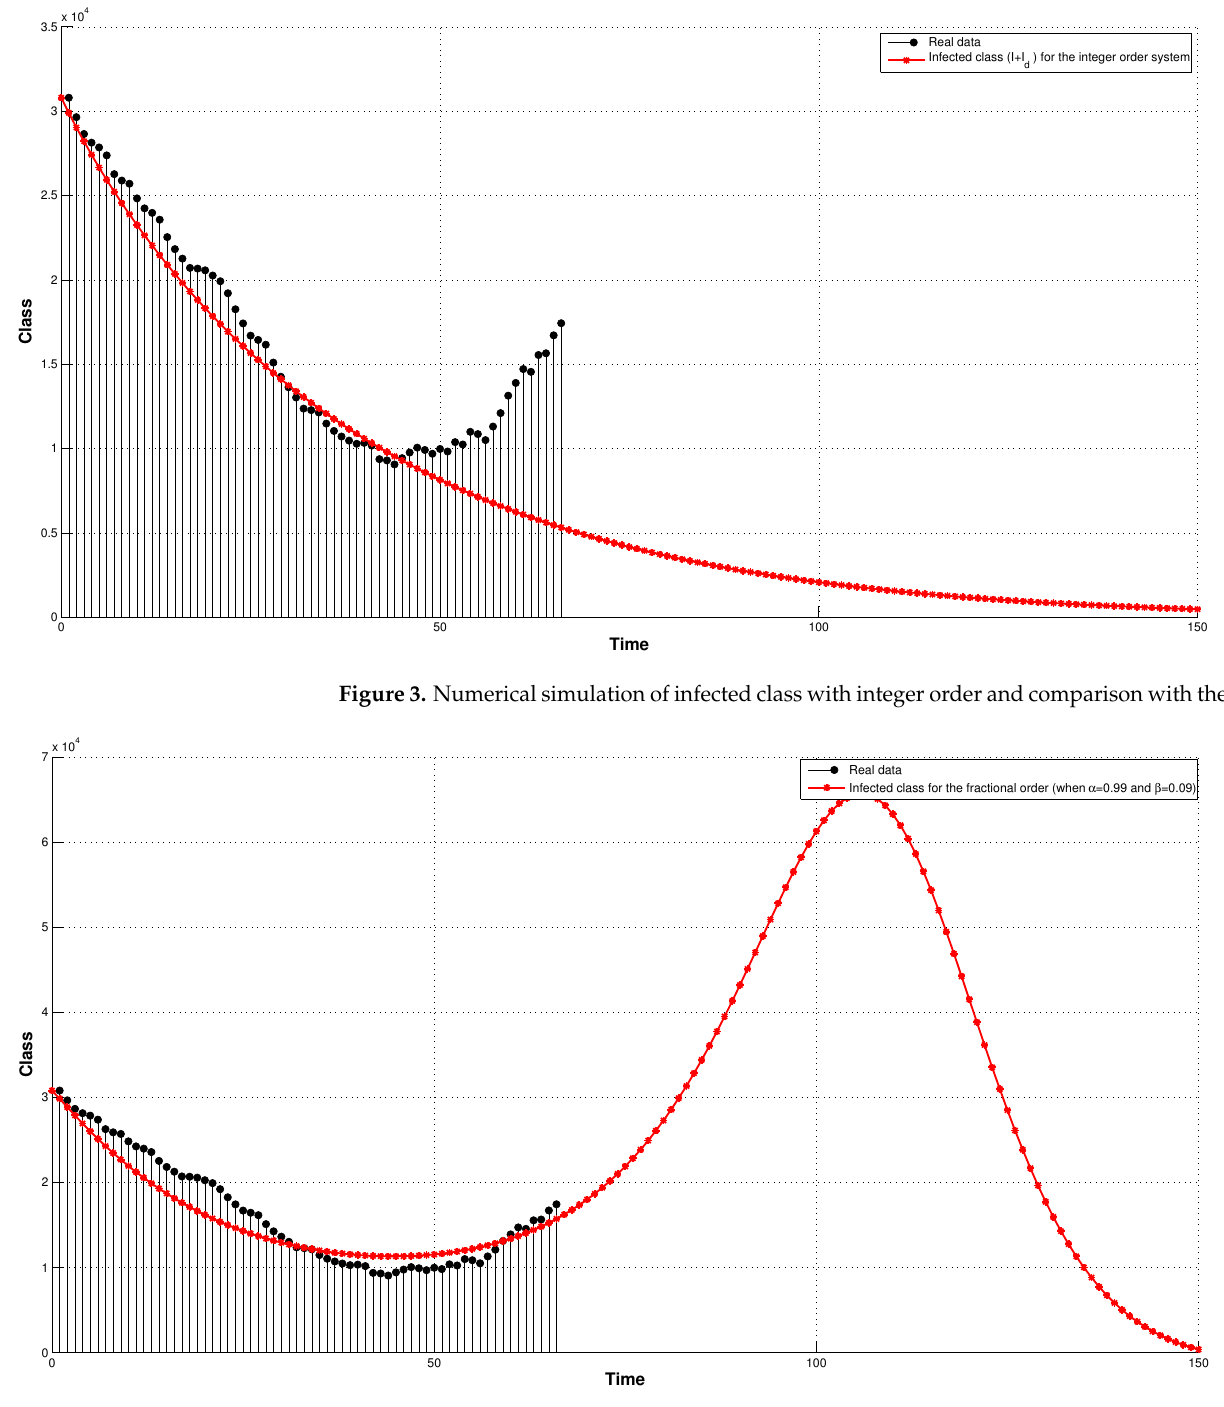
Figure 4. Numerical simulation of infected class with fractional-order system and comparison with real